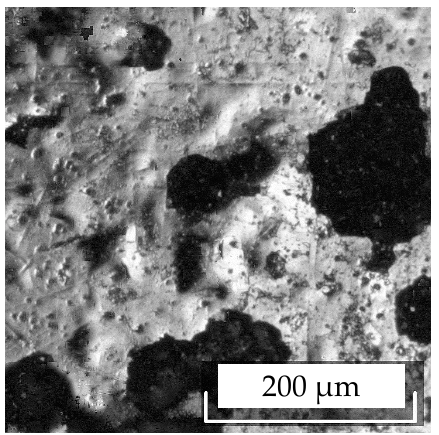
Figure 2. Microstructure of the ceramic sample with a molybdenum protective coating after the experiment. Conditions: NaCl–KCl–NaF (10 wt %)–K 2 NbF 7 (8 wt %) melt in contact with Nb, τ = 10 min, t = 750 ° С .